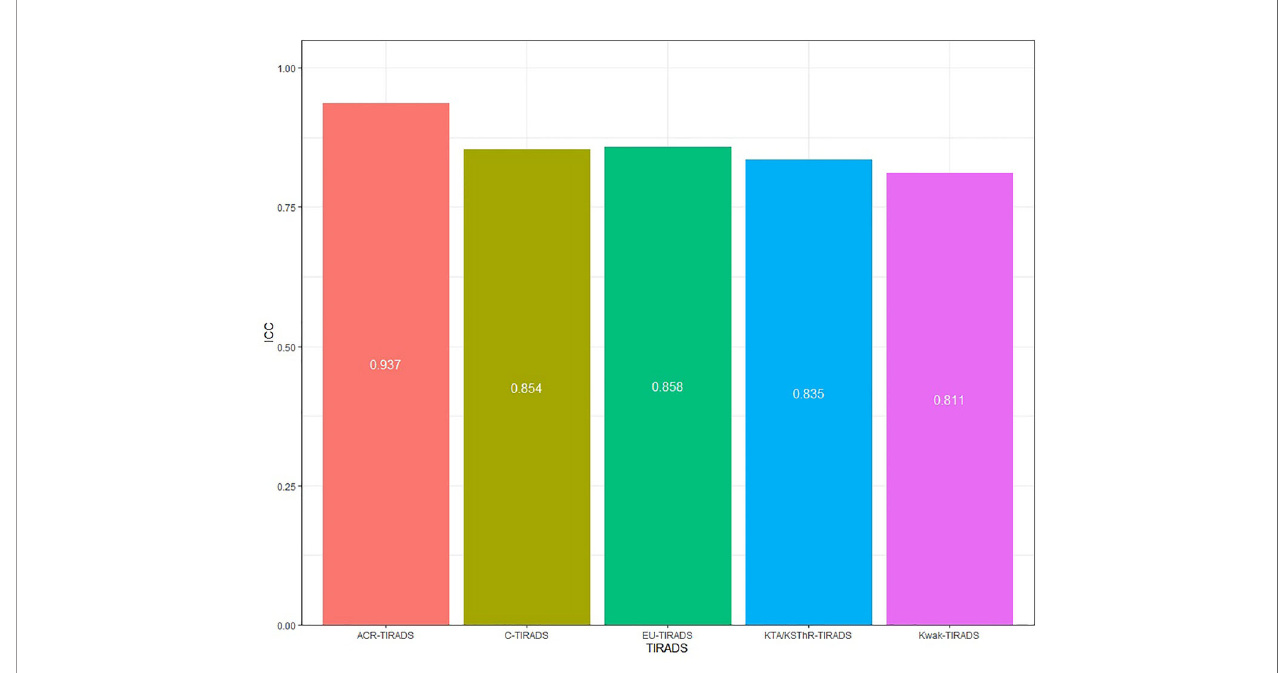
FIGURE 2 | The ICC values of fi ve guidelines.